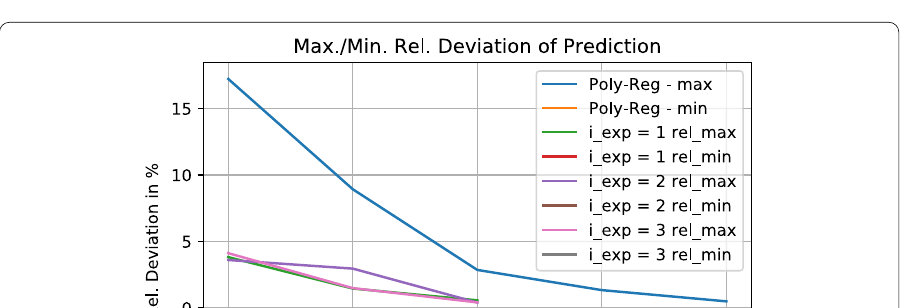
Fig. 25 Plate: convergence of score related to over-determination